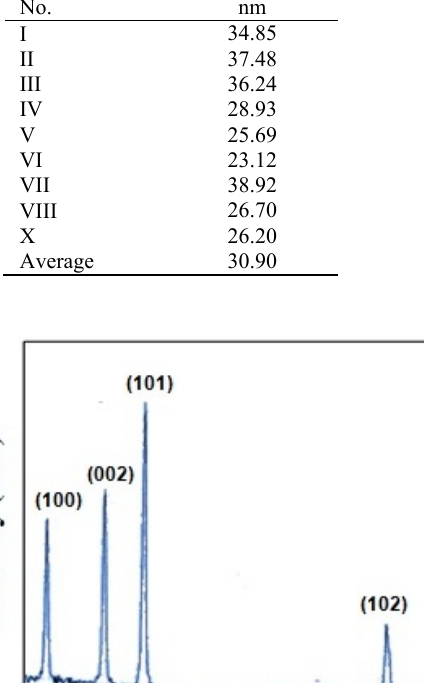
Table 4. Evaluation of the size of ZnO nanoparticles by Scherrer equation.